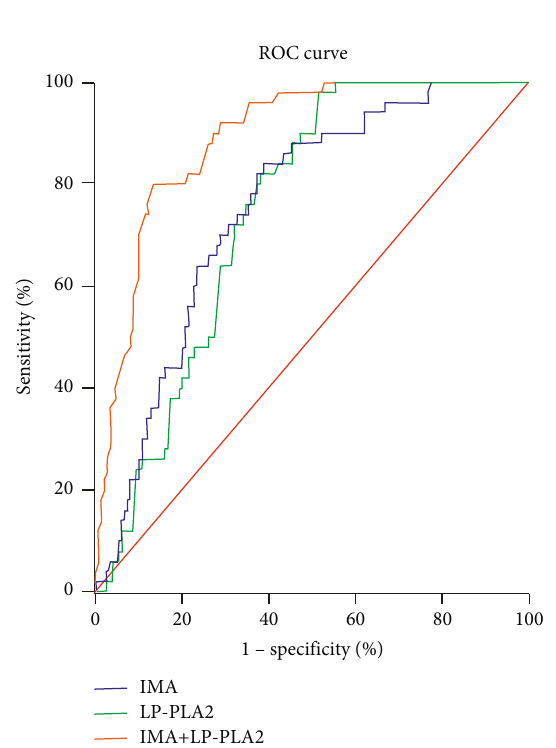
Figure 9: ROC curves of serum LP-PLA2 and IMA levels pre- dicting myocardial ischaemia in patients with CHD.